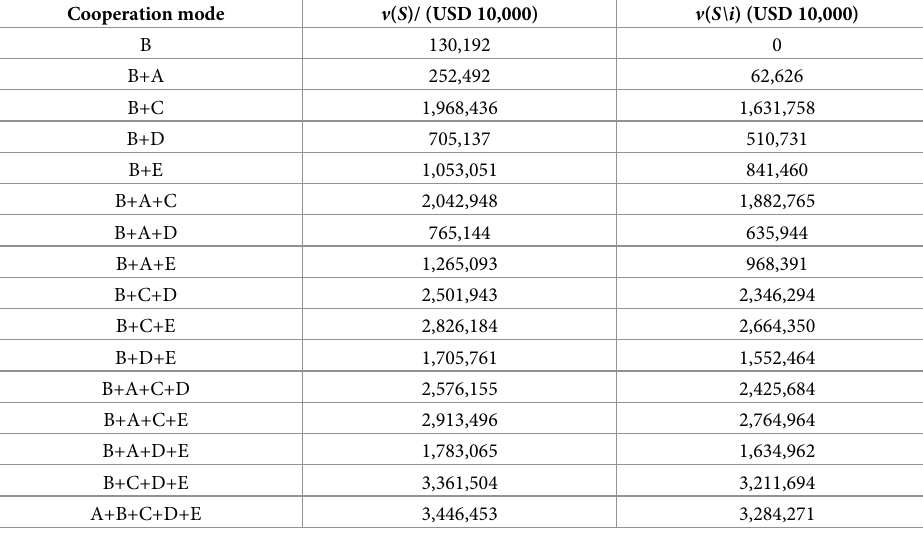
Table 7. Profits of 16 cooperation modes between Laos and other four